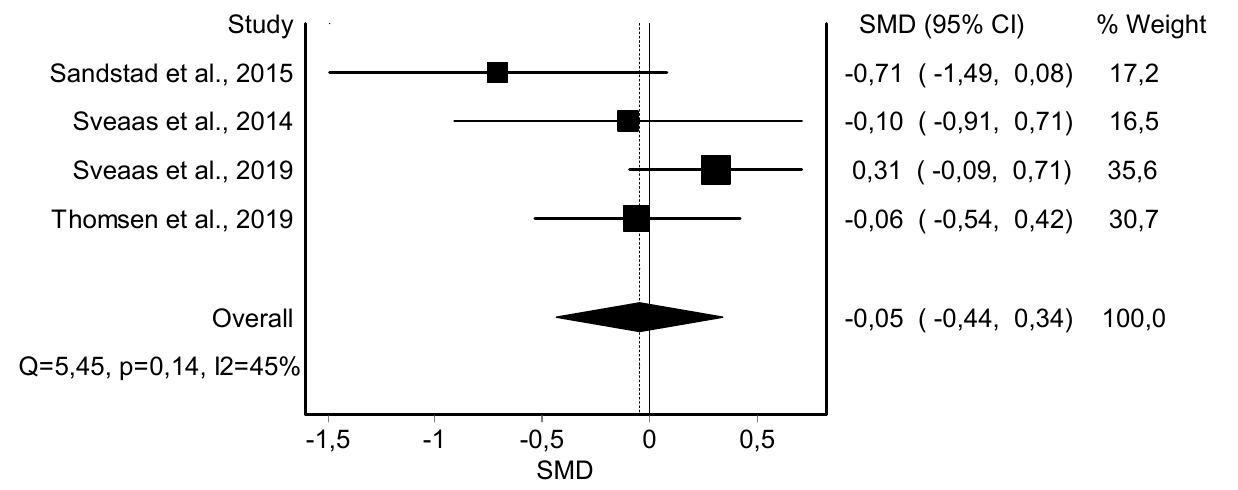
Figure 4. Synthesis forest plot of C-reactive protein variable. If the diagram (diamond-shaped) is in the negative zone (on the left of the figure and without touching the 0 line), it indicates statistically significant differences in favor of the HIIT intervention. The forest plot summarizes the results of included studies (SMD and weight). The small boxes with squares represent the point estimate of the effect size and sample size. The lines on either side of the box represent a 95% CI.